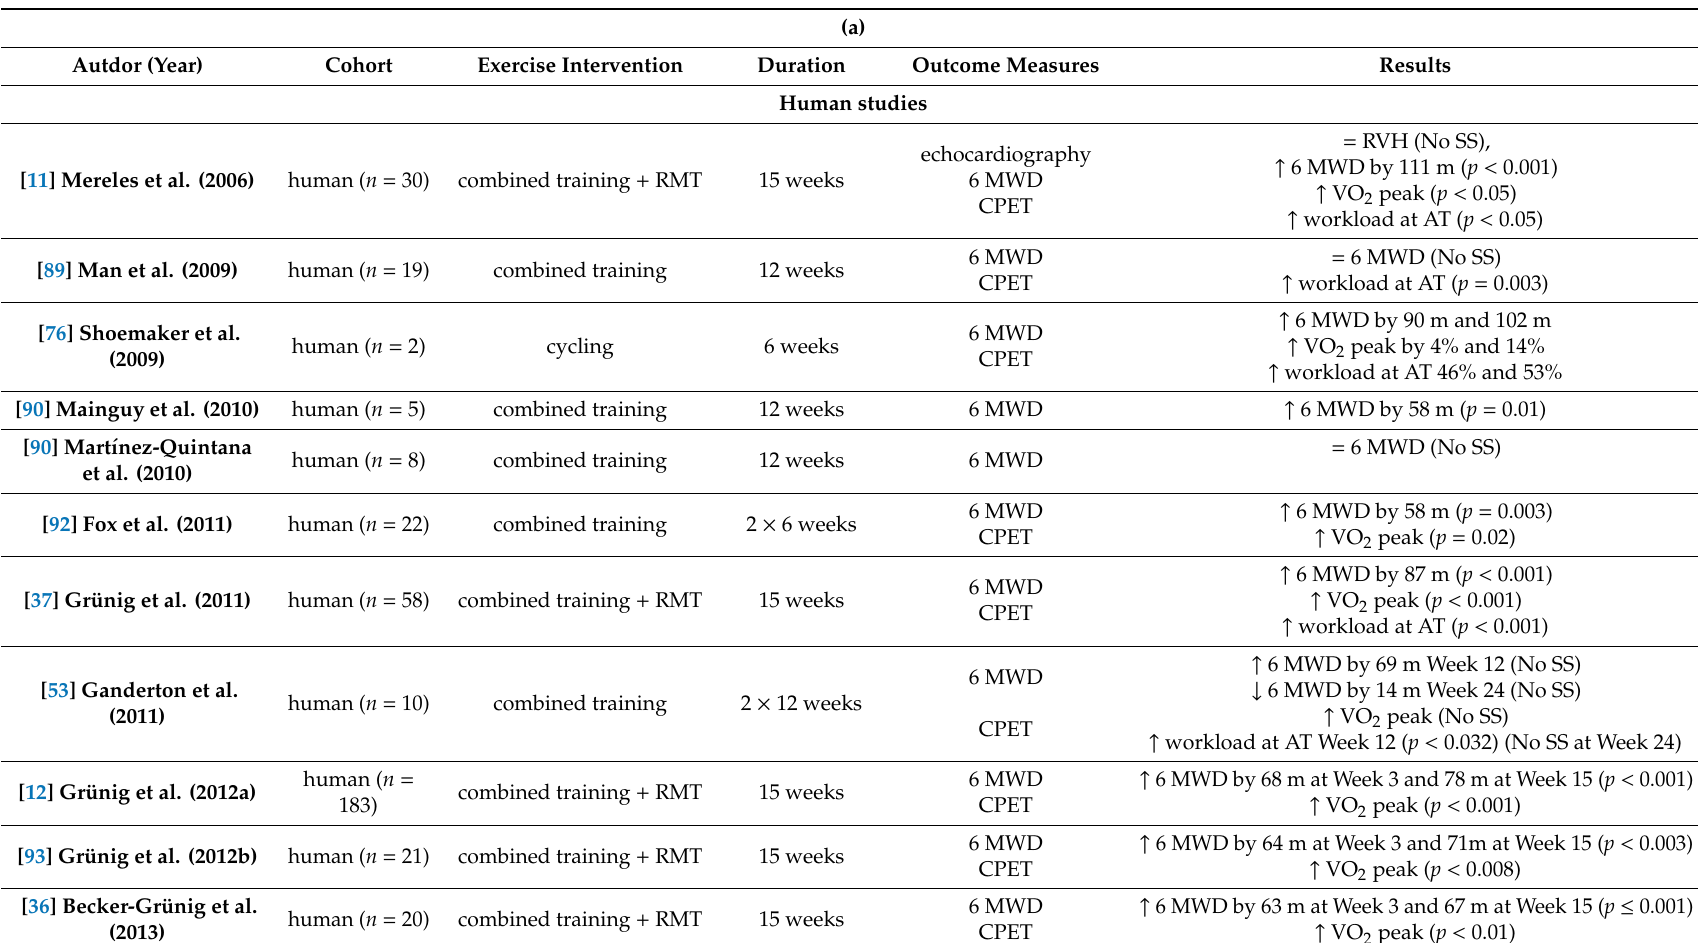
Table 7. Summary of studies examining functional and physiological factors ( n = 32). ( a ): Summary of human studies examining functional and physiological factors ( n = 20). ( b ): Summary of animal studies examining functional and physiological factors ( n =